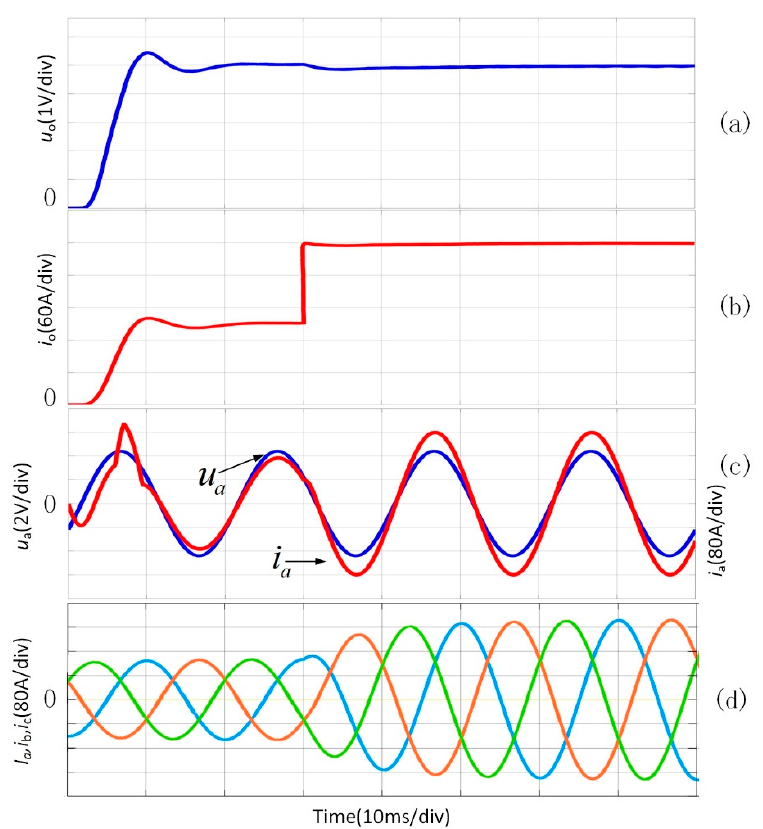
Figure 9. Simulation waves of the disturbed Lyapunov control: ( a ) Voltage wave; ( b ) Current wave; ( c ) A-phase voltage and current waves. ( d ) three-phase AC current waveform.